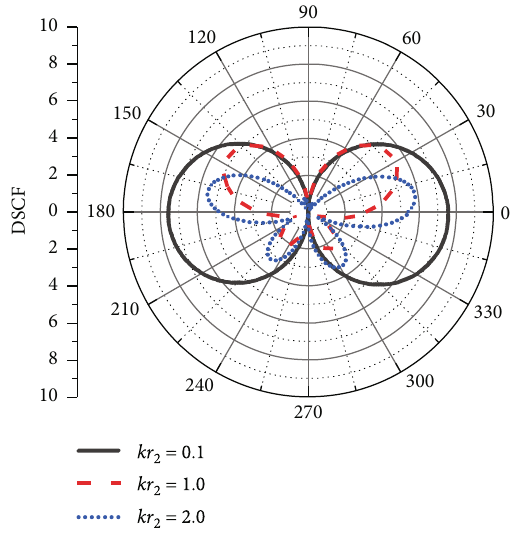
Figure 4: Degradation veri fi cation.